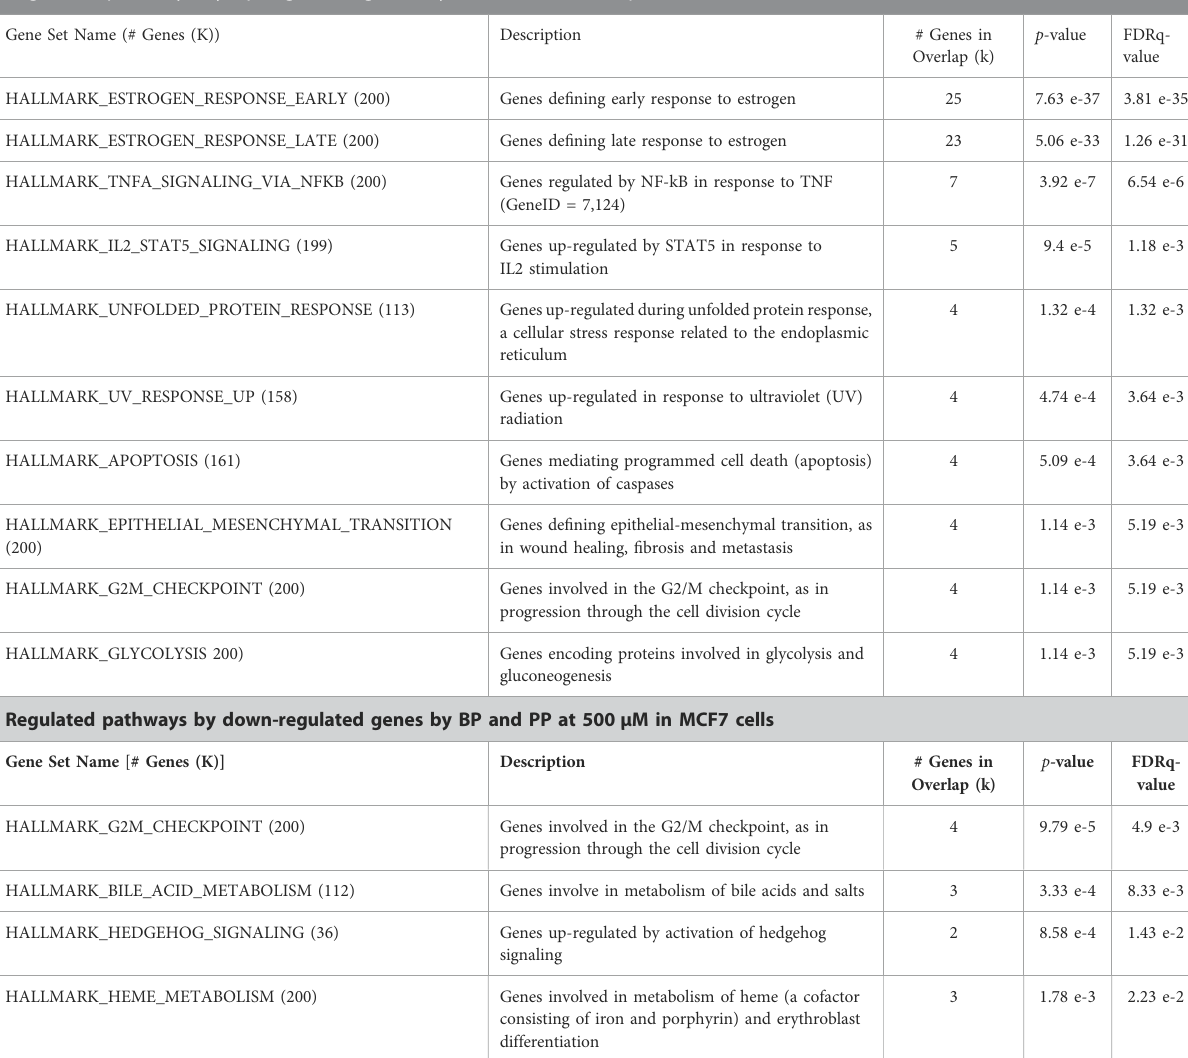
TABLE 2 Pathway enrichment analysis using the transcriptional pro fi le identi fi ed in the MCF-7 cells exposed to BP and PP at 500 μ M. For this analysis the Molecular Signatures Database (MSigDB v7.5.1) was utilized, and only the top enriched gene sets identi fi ed with the up-regulated or down-regulated genes (FDR < 0.05, and fold change of 1.2 > ) by both BP and PP (common genes affected in the same directions) are shown in the table. Regulated pathways by up-regulated genes by BP and PP at 500 μ M in MCF7